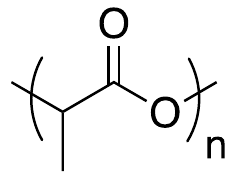
Figure 8. Proposed structure of 11 and structure of 12 .